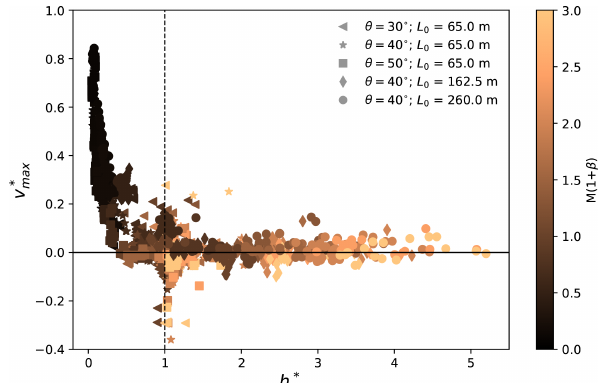
Figure 7. Unified relation between the scaled maximum velocity and the scaled deposit